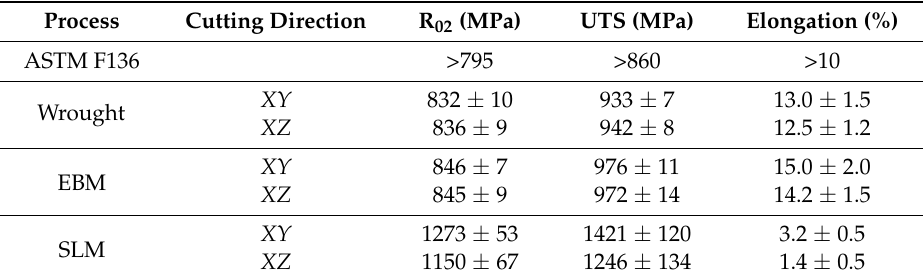
Table 4. Tensile properties of fabricated samples.